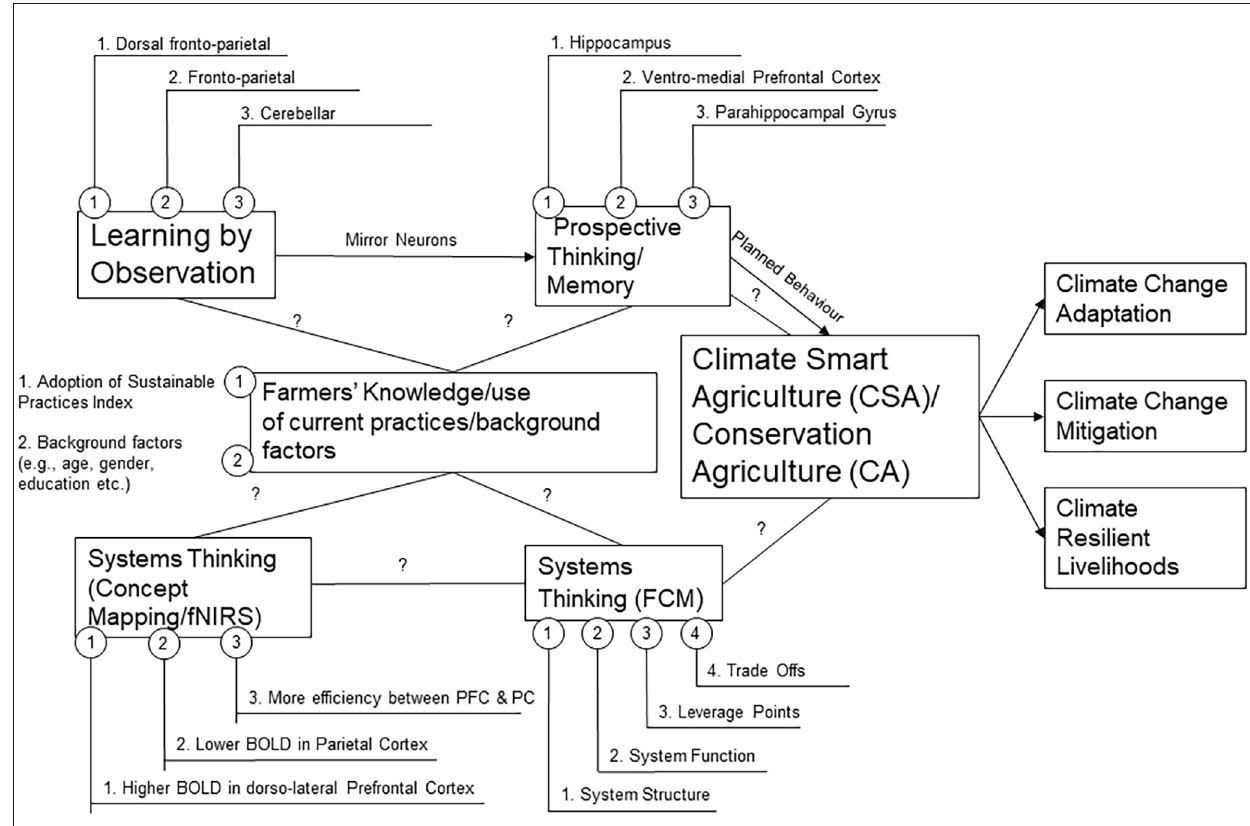
FIGURE2 Theory of change. Please note some of the indicators/brain regions highlighted in Figure 2 are based on a scan of the literature and/or the use of fNIRS (e.g., under concept mapping). This might be slightly different with the use of NIRS (focus on the prefrontal